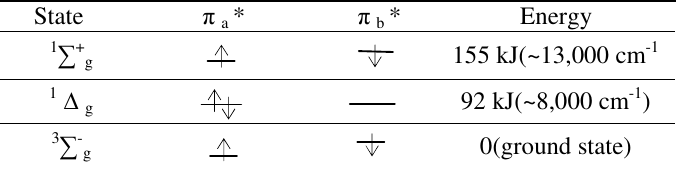
Table 1. States of O